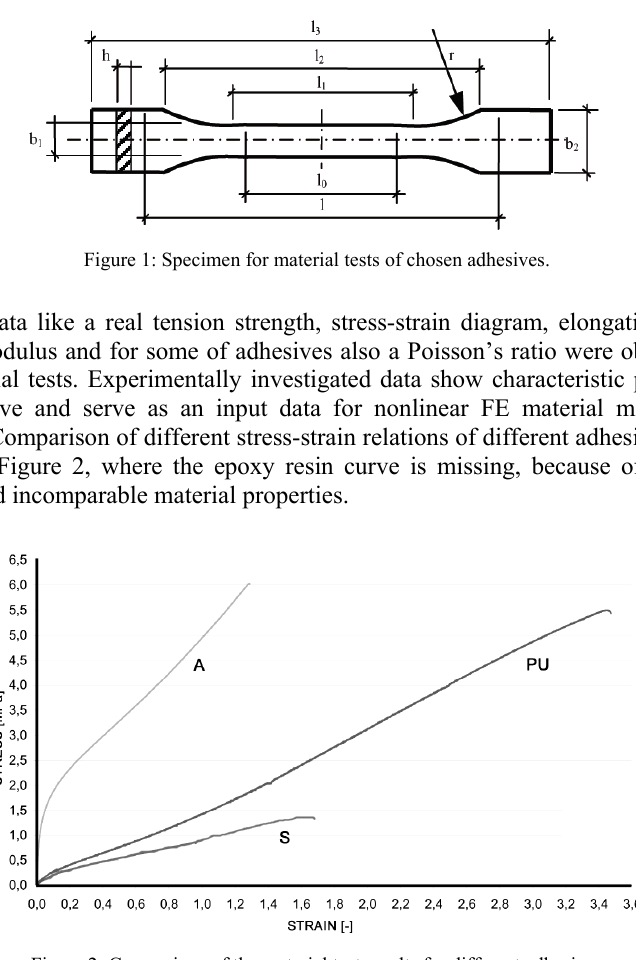
Figure 2: Comparison of the material test results for different adhesives (S- silicone, A- acrylic, PU- Polyurethane booster